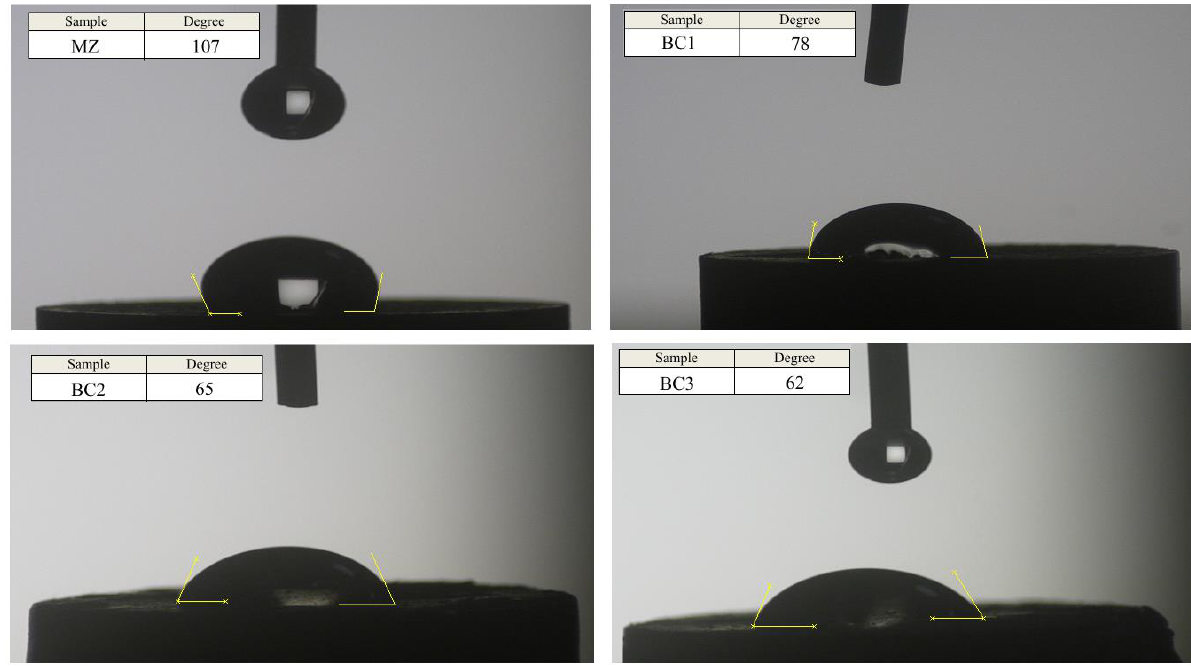
Figure 6. Contact angle for MZ, BC1, BC2 and BC3 composites after SPS process.